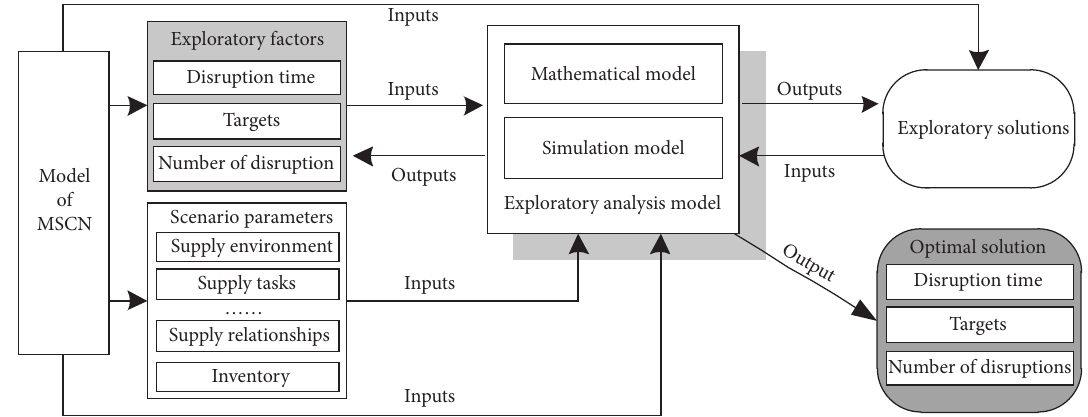
Figure 3: Simulation framework.